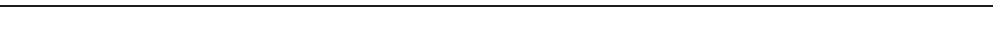
Fig. 5 A normalization model can explain diverse ML integration rules. a Schematic normalization model for an IT cell responding to two objects (adapted from Reynolds et al. 11 ). The red line indicates the excitatory input, and the blue line indicates the inhibitory input. R indicates the fi ring rate of the cell; w 1 , w 2 indicate the strength of the inhibitory input associated with the two objects; c 1 , c 2 indicate the contrast energy of the two objects; A , B represent the responses to object 1, object 2 alone at high contrast. b According to the normalization model, the response R can be written as a ratio between the summed excitatory input and the summed inhibitory input. When w 1 is much larger than w 2 , the response approximates winner-take-all. When w 1 is similar to w 2 and the contrast of two stimuli are same, the response approximates averaging. c Estimates of the strength of the inhibitory input for different stimuli (indicated by the size of each circle), based on the strong selectivity for faces vs. objects in ML and the spatial tuning properties of ML. Combining these estimates with the normalization equation in b allows prediction of the integration rules used by ML cells across all stimulus conditions tested in this paper (Table 1). d The average LFP amplitude for four conditions (contralateral face, ipsilateral face, contralateral object, ipsilateral object) obtained from the face-object experiment when the face and object were presented in isolation at highest contrast level. The LFP amplitude was de fi ned as the difference between negative peak and positive peak in a time window of 150 – 350 ms after stimulus onset. e The average LFP amplitude for four conditions (face in the upper visual fi eld, face in the lower visual fi eld, object in the upper visual fi eld, object in the lower visual fi eld) when the face and object were presented in isolation with highest contrast level. f The normalization model fi t to the face-object experiment when faces and objects were presented horizontally (see Methods for details). Line indicates model fi t, circles indicate observed data (same as Fig. 2b, e). g Same as f , for faces and objects presented vertically. h Relative weights (normalized by the maximum weight) obtained from model fi ts for faces and objects in f . i The correlation between the observed responses and the responses based on the normalization model fi t when faces and objects were presented horizontally. j Relative weights (normalized by the maximum weight) obtained from model fi ts for faces and objects in g . k Same as i , for face and objects presented